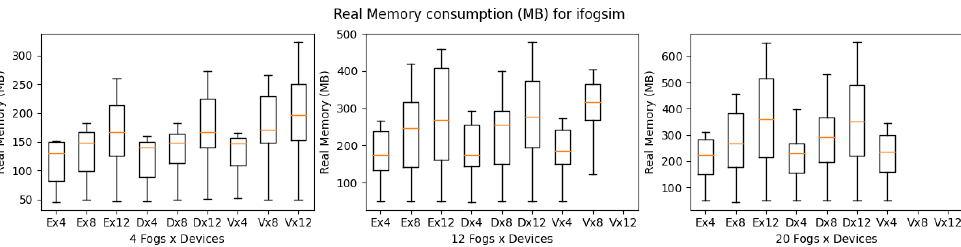
Figure 12. Real memory consumption for iFogSim during simulation (E: eHealth; D: DCNS; V: VRGame).